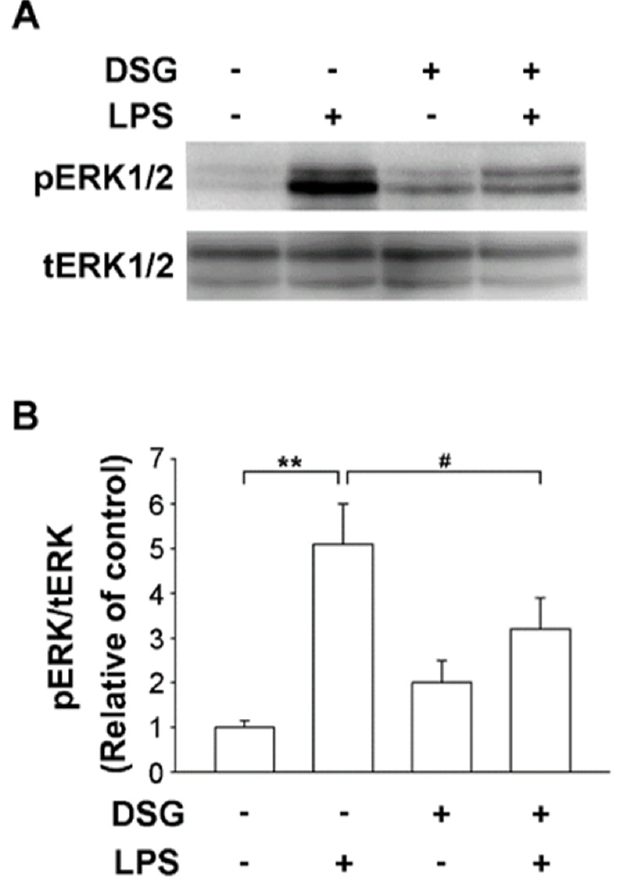
Figure 3. Effects of diosgenin on LPS-induced ERK activation in primary rat microglia. Primary rat microglia were pretreated for 30 min with vehicle or the indicated concentrations of diosgenin before treatment with or without LPS for 30 min. The cells were harvested and phosphorylated ERK 1/2 (pERK) and total ERK 1/2 (tERK) levels were analyzed using Western blotting ( A ). Quantitative densitometry was used to calculate the ratio of pERK to tERK, which was normalized to the control ( B ). The results are presented as the means ± SD obtained from three independent experiments using different batches of isolated cells. ** p < 0.01 compared with the control; # p < 0.05 compared with LPS-treated cultures.